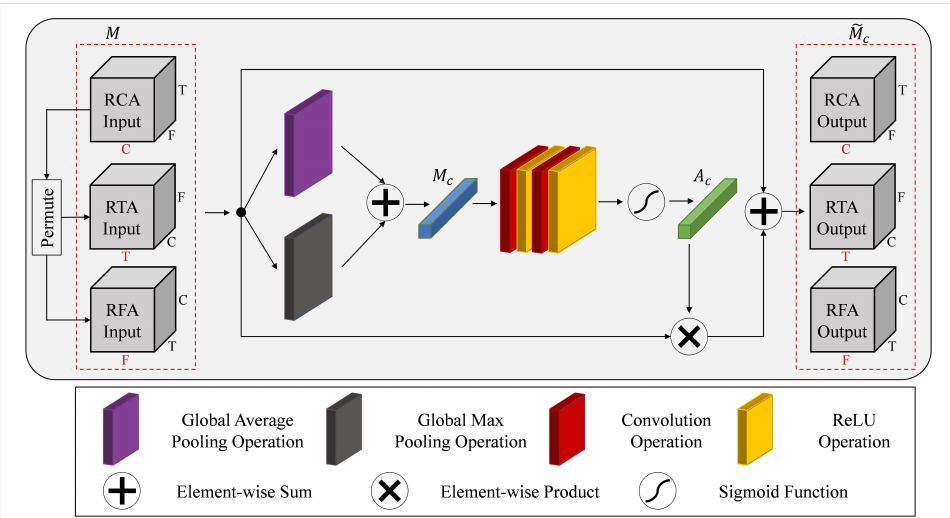
Figure 3. Structure of residual time–frequency mixed attention